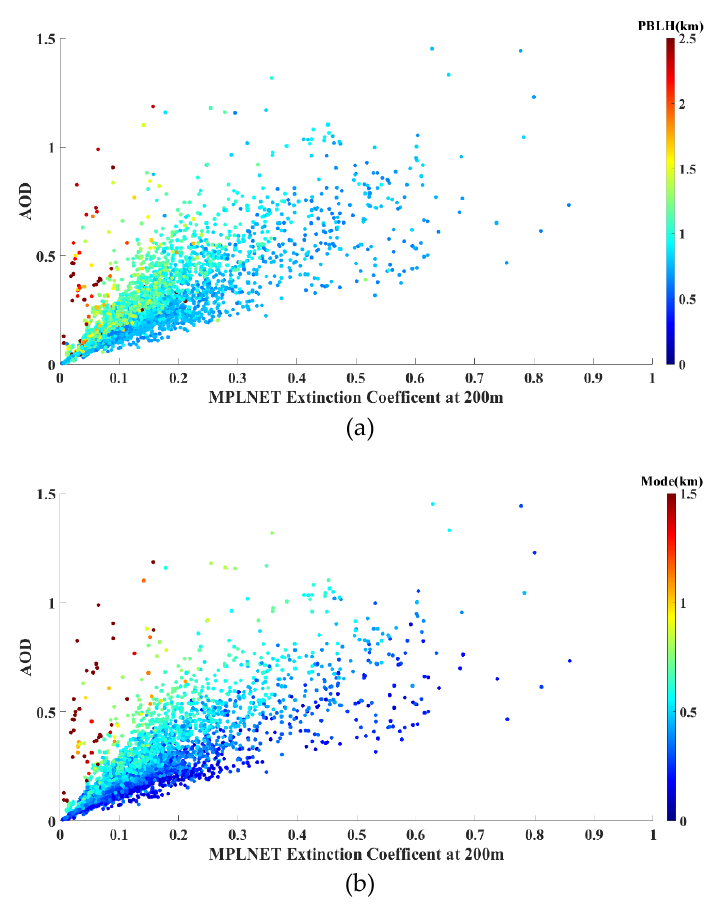
Figure 3. Scatter plot of the AOD and surface extinction coefficient (200 m) for the ( a ) PBLH and ( b ) Mode height, which are denoted by the colored scale.